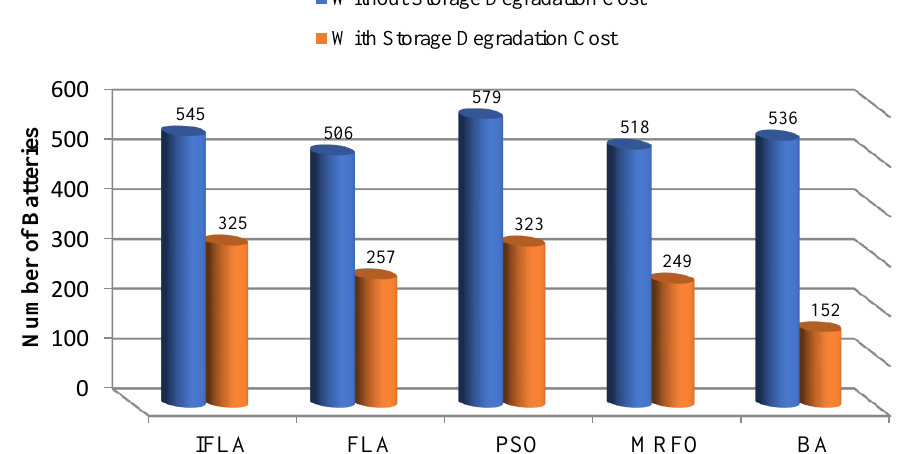
Figure 10. Number of batteries without and with BDC in WT/Battery scheduling using the IFLA.